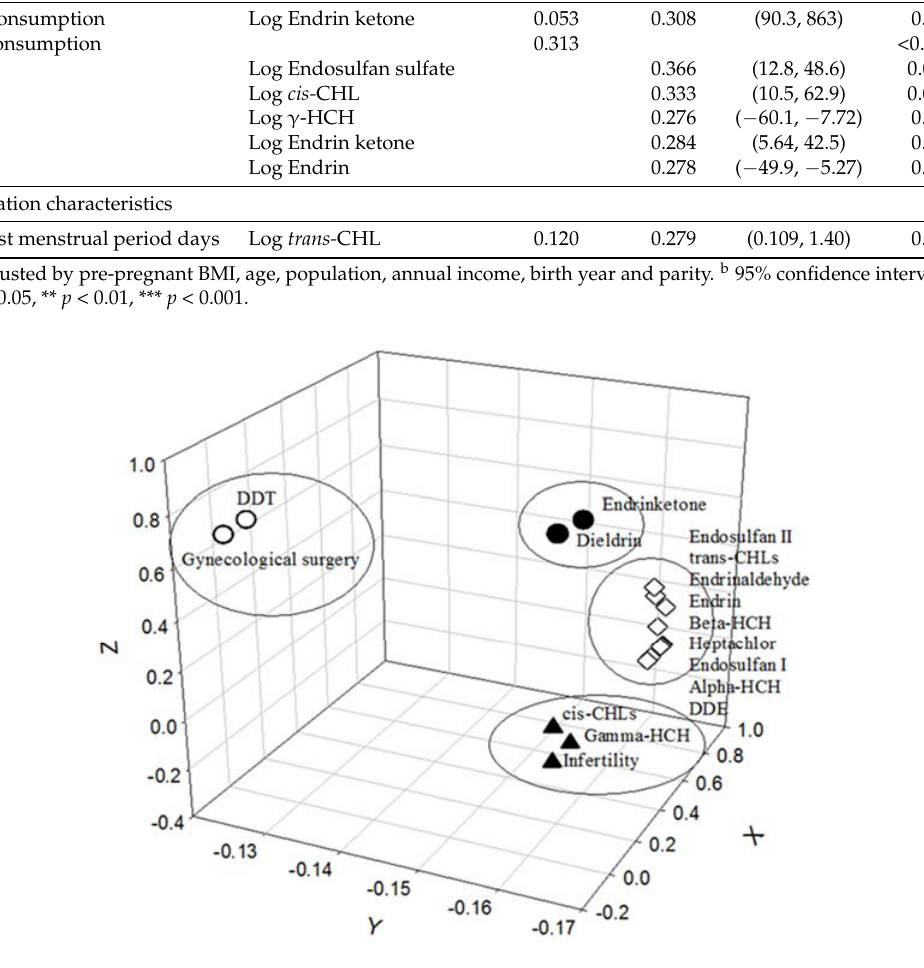
Figure 2. Women who received medical treatment for infertility associated with breast milk cis ‐ CHL and γ‐ HCH or who had undergone gynecological surgery were correlated to breast milk DDT by performing the principal component analysis (PCA).